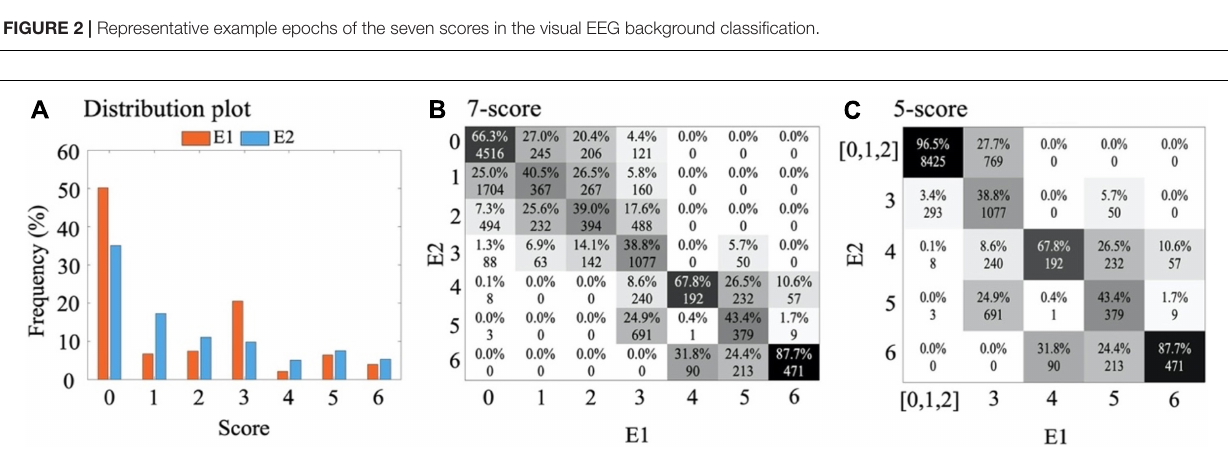
FIGURE 3 | Visual annotations. (A) Distribution plot (in percent) of visual annotations for two experts, E1 and E2. (B) Confusion matrix between E1 and E2 for classification of 7-score and, (C) for classification of 5-score after combining scores 0, 1, and 2 into one score. The absolute values present the number of epochs corresponding to each score and the percentages of each column sum up to